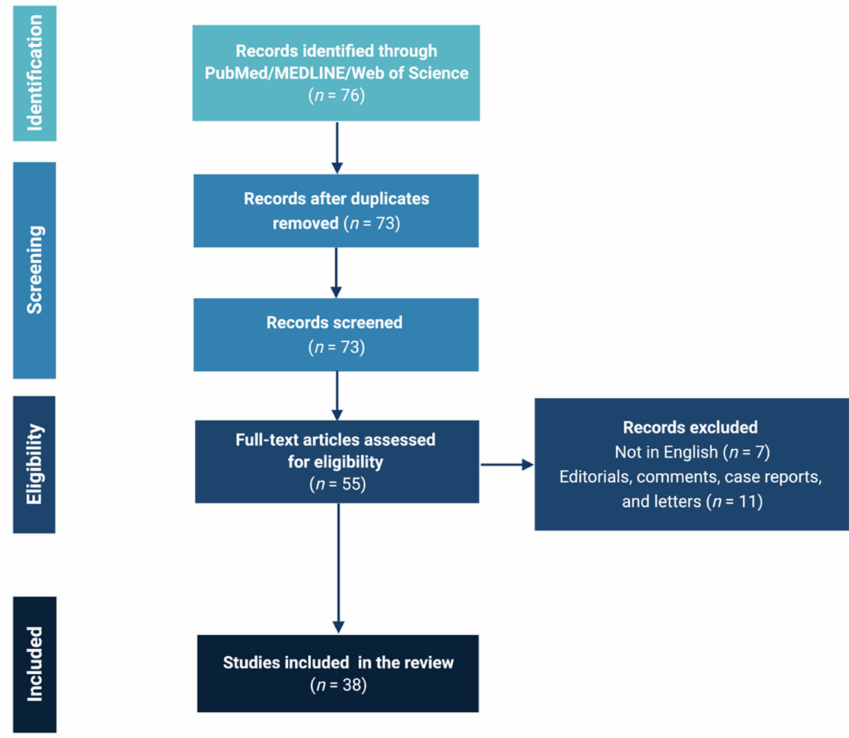
Figure 1. PRISMA flow